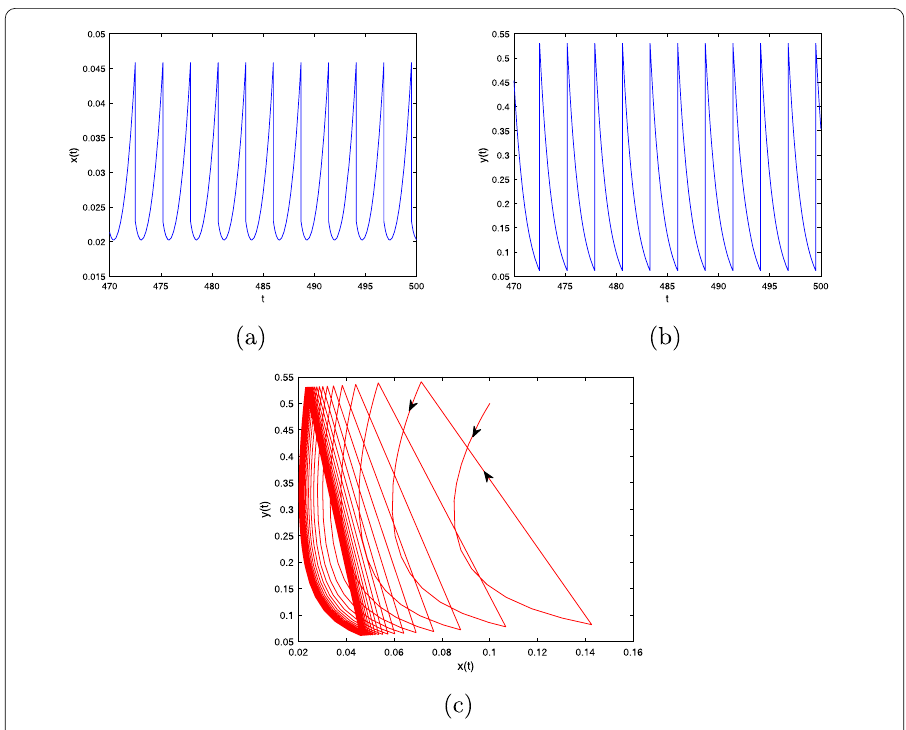
Figure 4 The numerical simulation demonstrates the occurrence of a stable positive periodic solution of the impulsive system in Eq. (7). Here, the parameter values and the initial condition are exactly the same as used in Fig. 2 except T = 2.7 > T max = 2.47: ( a ) the time series simulation of the prey density x ( t ); ( b ) the time series simulation of the predator density y ( t ); ( c ) the trajectory simulation plotted on the xy